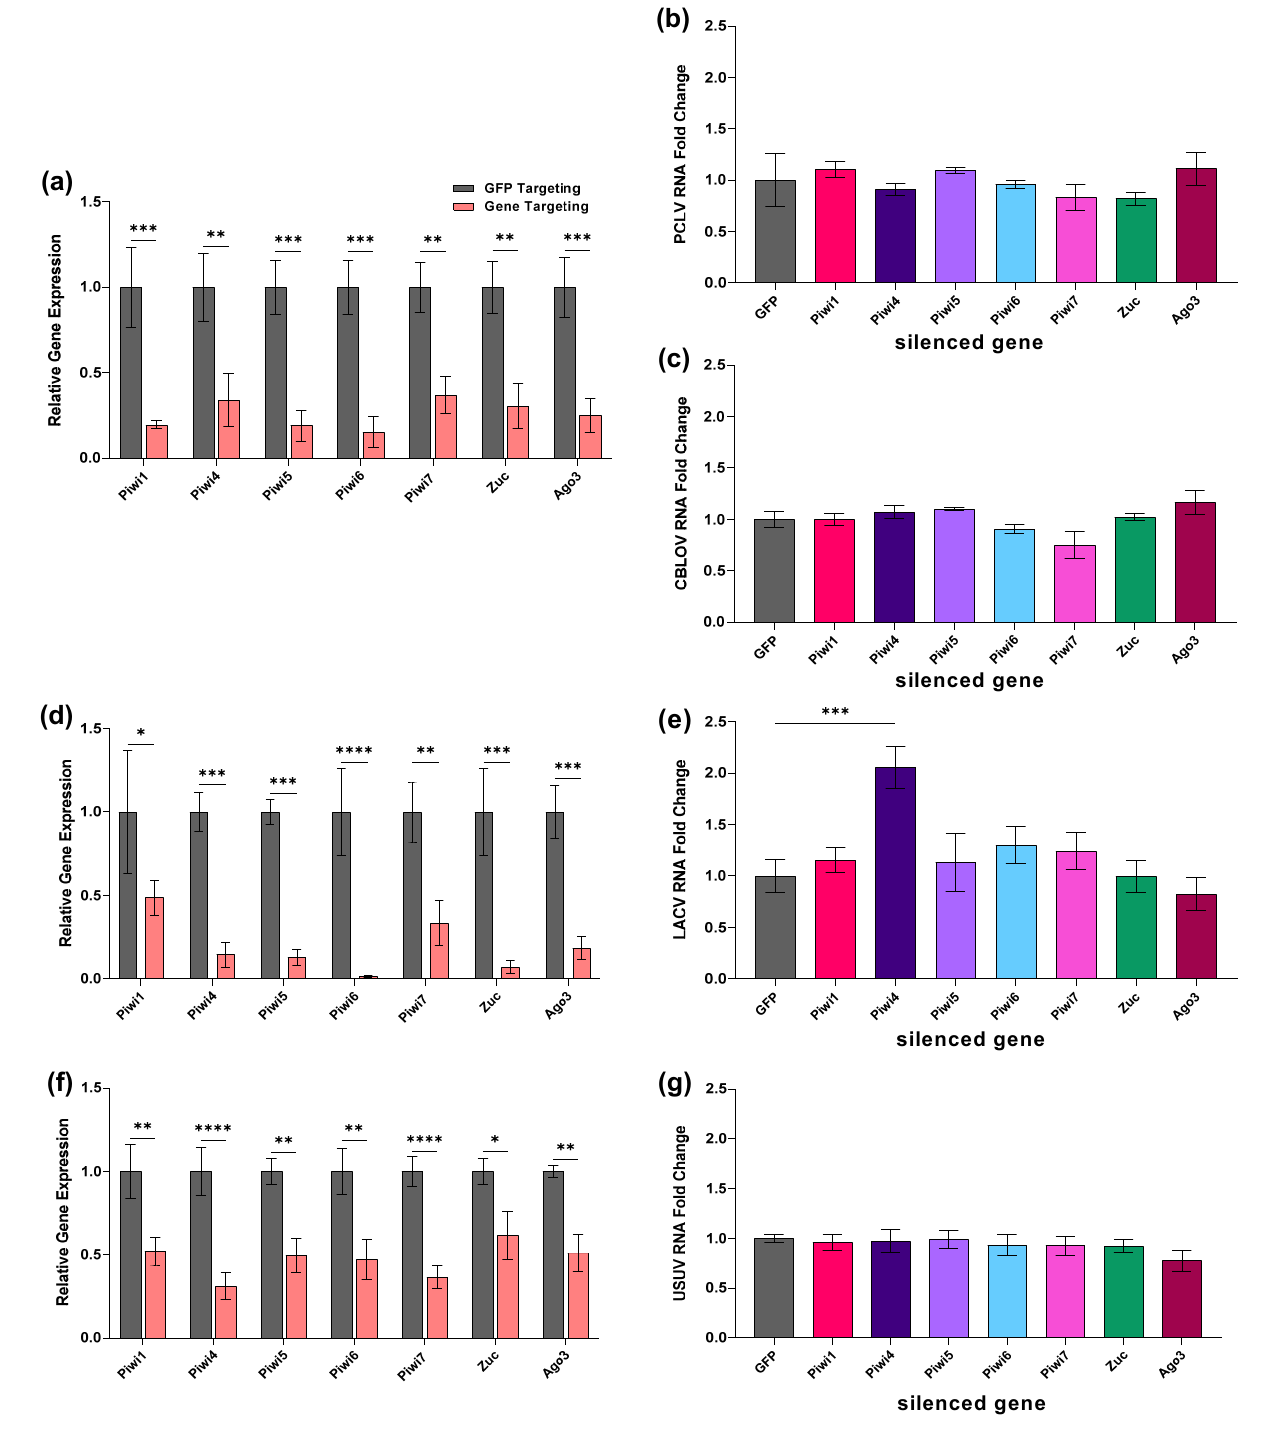
Figure 3. Impact of Cx. tarsalis piwi gene silencing on virus replication. CT cells were left uninfected ( a – c ) or were infected 2 days post-transfection with either LACV MOI 10 ( d , e ), USUV MOI 50 ( f , g ). Cellular RNA was extracted at 2 dpi ( a – g ). Silencing efficiency of PIWI genes ( a , d , f ) and viral RNA levels ( b , c , e , g ) were determined by qRT ‐ qPCR. Bars are the mean +/ − SEM of 2 independent experiments with 3 biological replicates each. Significant changes in RNA abundance compared to the GFP control are shown as * p < 0.05, ** p < 0.01, *** p < 0.001, **** p < 0.0001.